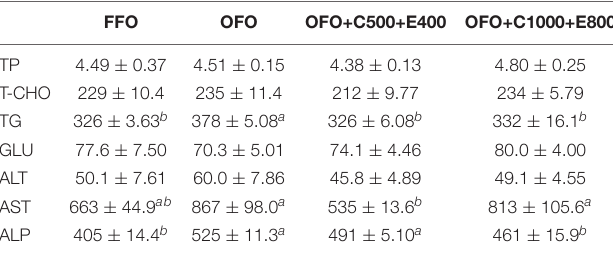
Values are mean of triplicate groups and presented as mean ± SE. Values in the same row with different superscript letters are significantly different (P < 0.05).